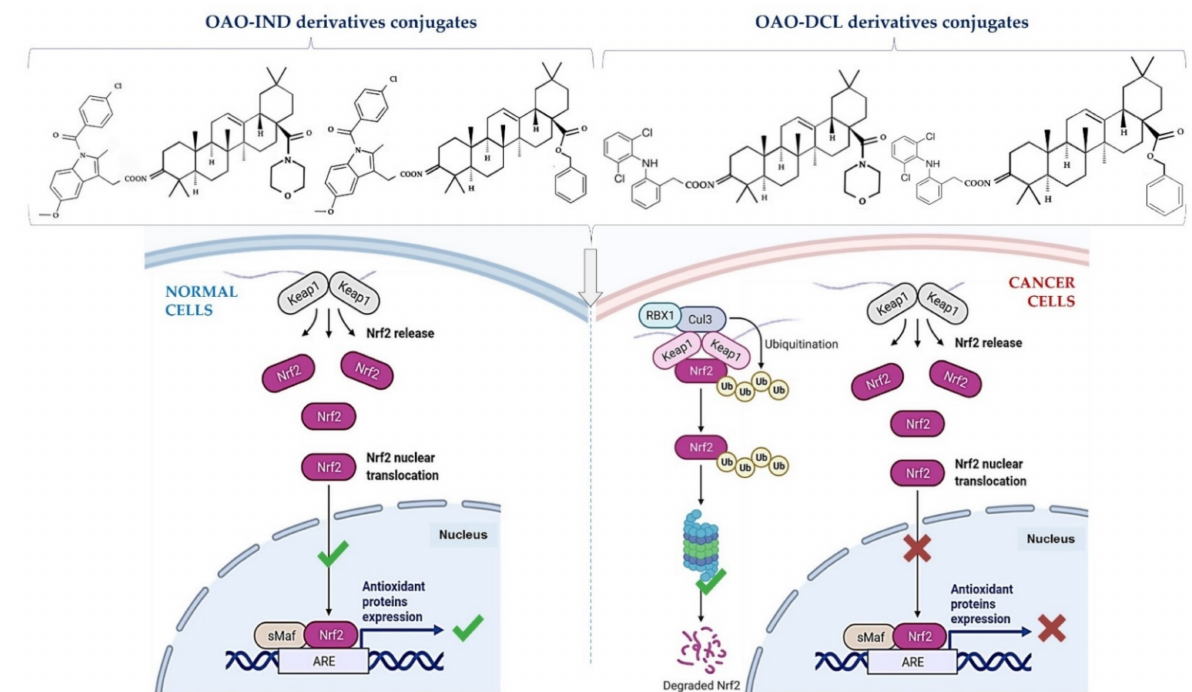
Figure 3. OAO-IND and OAO-DCL exert different effects on the Nrf2 pathway in normal hepatocytes and HCC cells. OAO–IND conjugates increase the activation of Nrf2 in normal hepatocytes by 25–55%, but inhibit its activation in HCC cells (by 30–40%) [62]. Similarly, OAO–DCL conjugates enhance the activation of Nrf2 in normal hepatocytes by 22–46% and inhibit activation of Nrf2 in HCC cells by 21–55% [39]. Figure was created with BioRender.com by the authors.